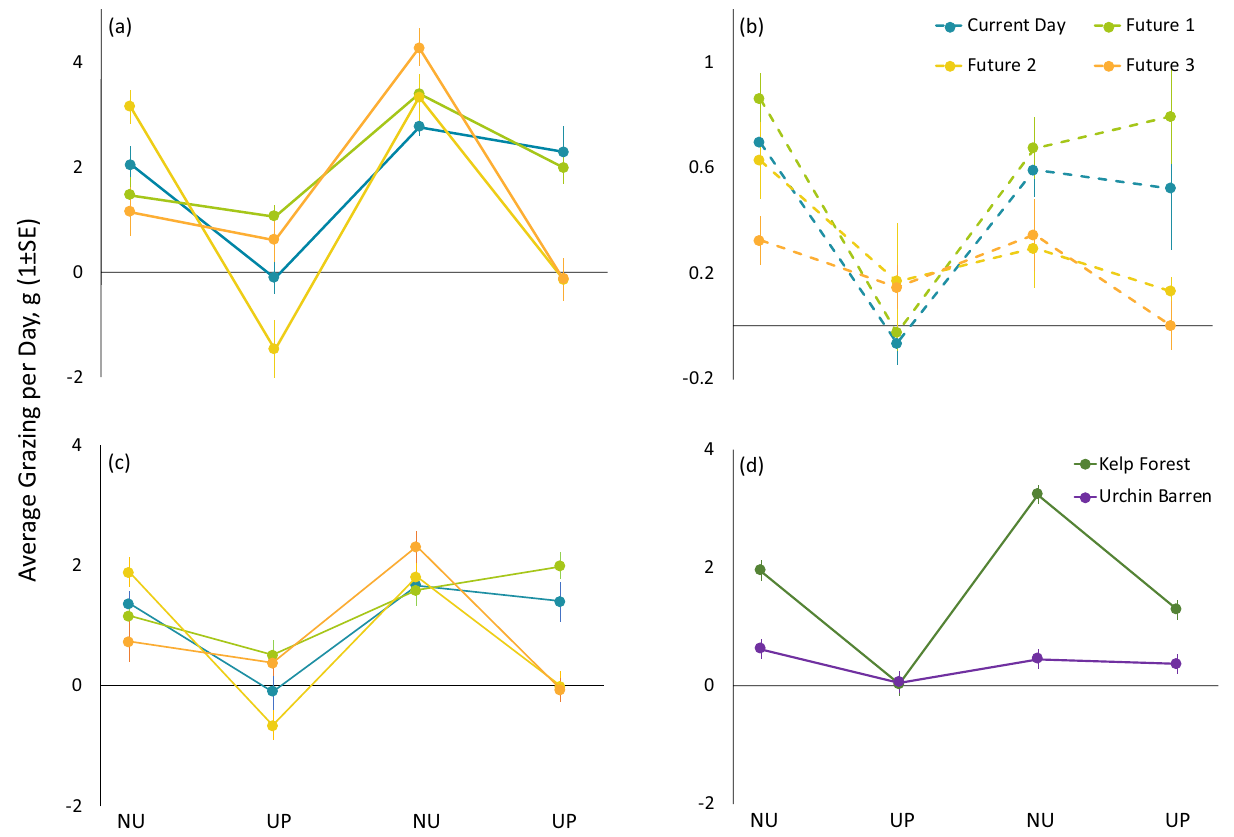
Figure 2. Average (1 ± SE) grazing rates through time (during each non-upwelling and upwelling event) for ( a ) kelp forest and ( b ) urchin barren urchins, and ( c ) urchins pooled across habitat in each of the four upwelling severity treatments; and ( d ) kelp forest and urchin barren urchins pooled across upwelling severity treatments. KEY: NU non-upwelling event, UP upwelling